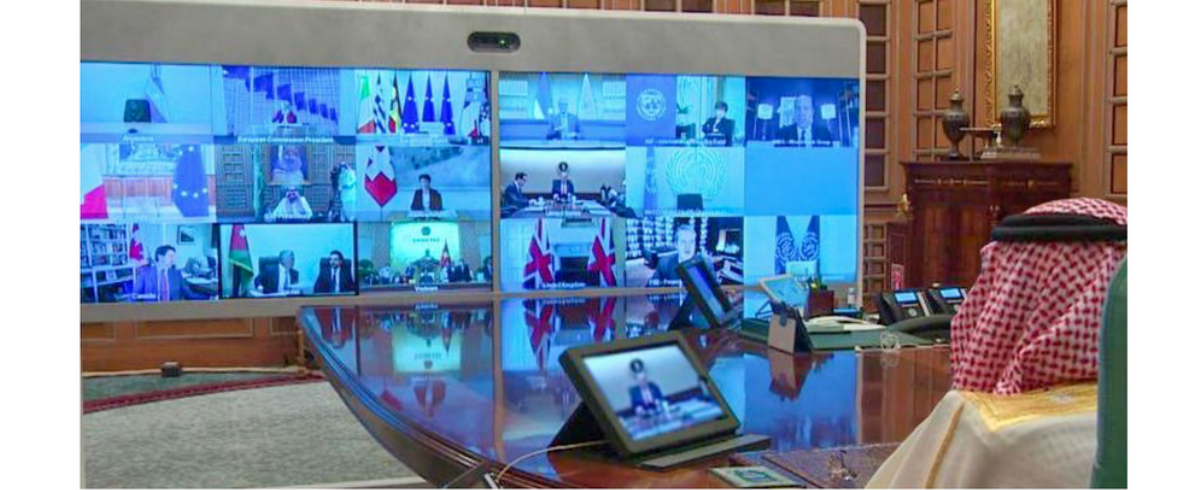
Figure 3. Snapshot of the G20 Extraordinary Virtual Leaders’Summit on COVID-19, hosted by the Saudi King Salman Bin Abdulaziz, on March